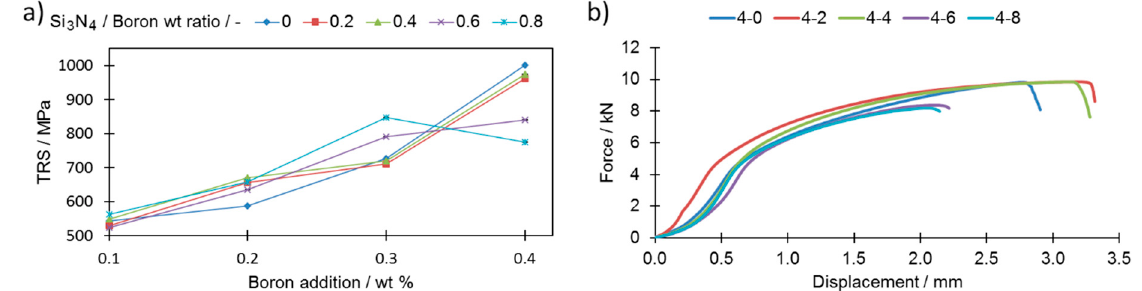
Figure Figure 12. a ) Influence of Si 3 N 4 and boron additions on transverse rupture strength (TRS) b ) representative bending curves of selected samples. Numerical data are available in Table S7 in the Supplementary Material.